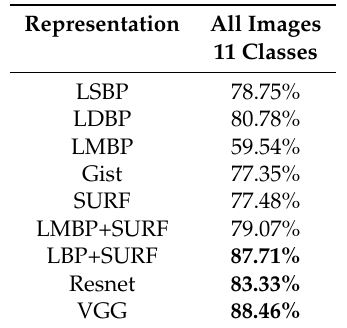
Table 1. Performance of an SVM Classifier using different feature representations. These results are the average performance after using four test sets (4-fold cross-validation). The 3-top scores are shown in bold.